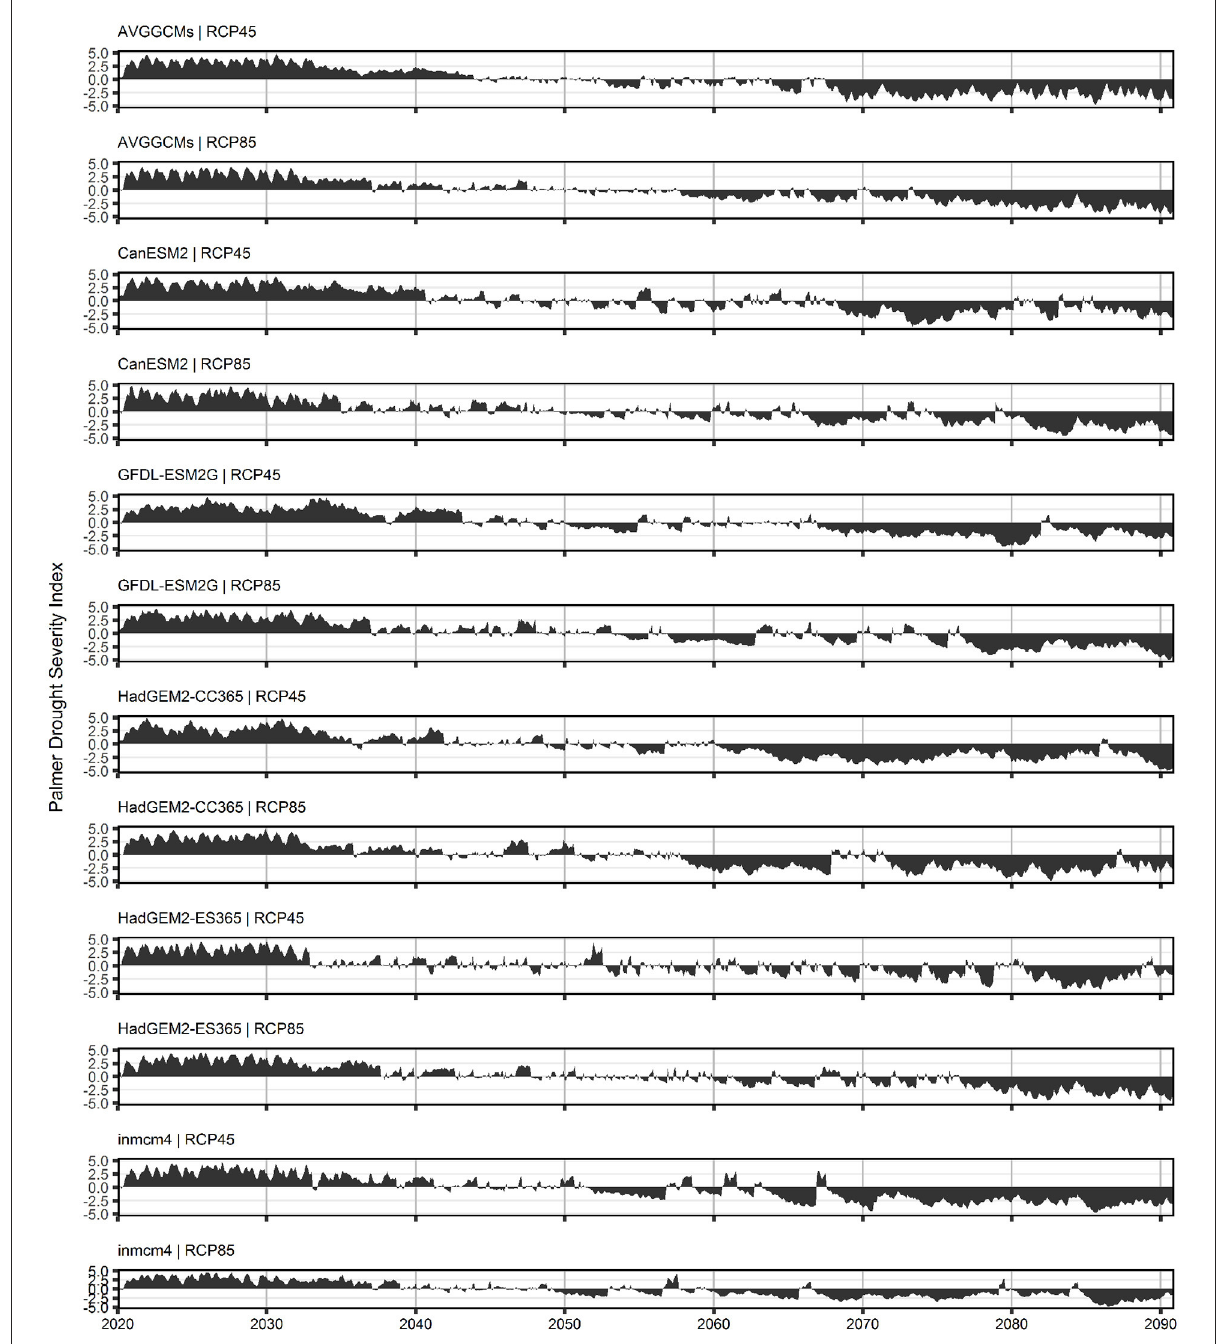
FIGURE2 Palmer drought severity index (PDSI) for five GCMs and average of GCMs (top two: AVGGCMS) under RCP 4.5 and RCP 8.5 for future projection of 2020–2090 in the YRB. Positive PDSI indicates moist condition and negative PDSI indicates drought condition. Classification of PDSI follows extreme wet ( ≥ 4), normal ( = 0), and extreme drought ( < = −